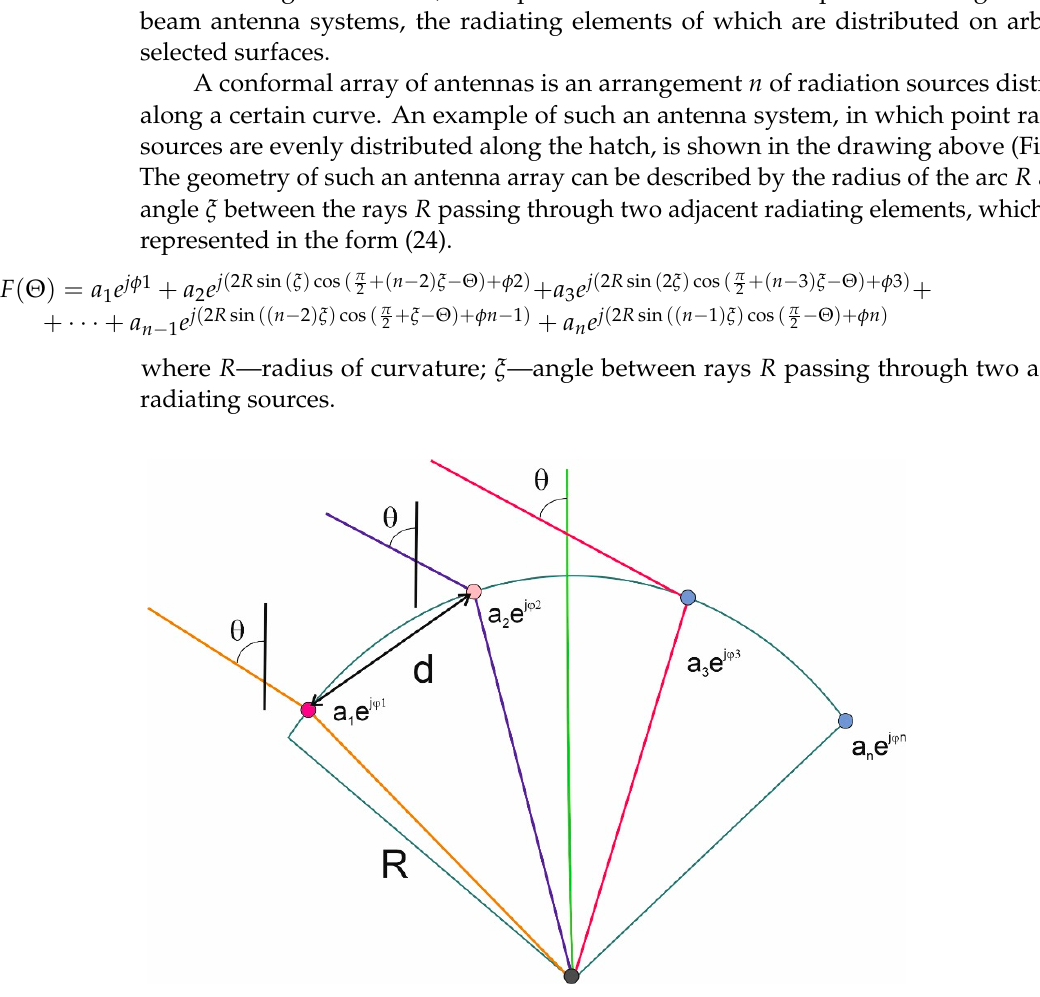
Figure 4. Antenna array—receiving signals in the GNSS receiver.